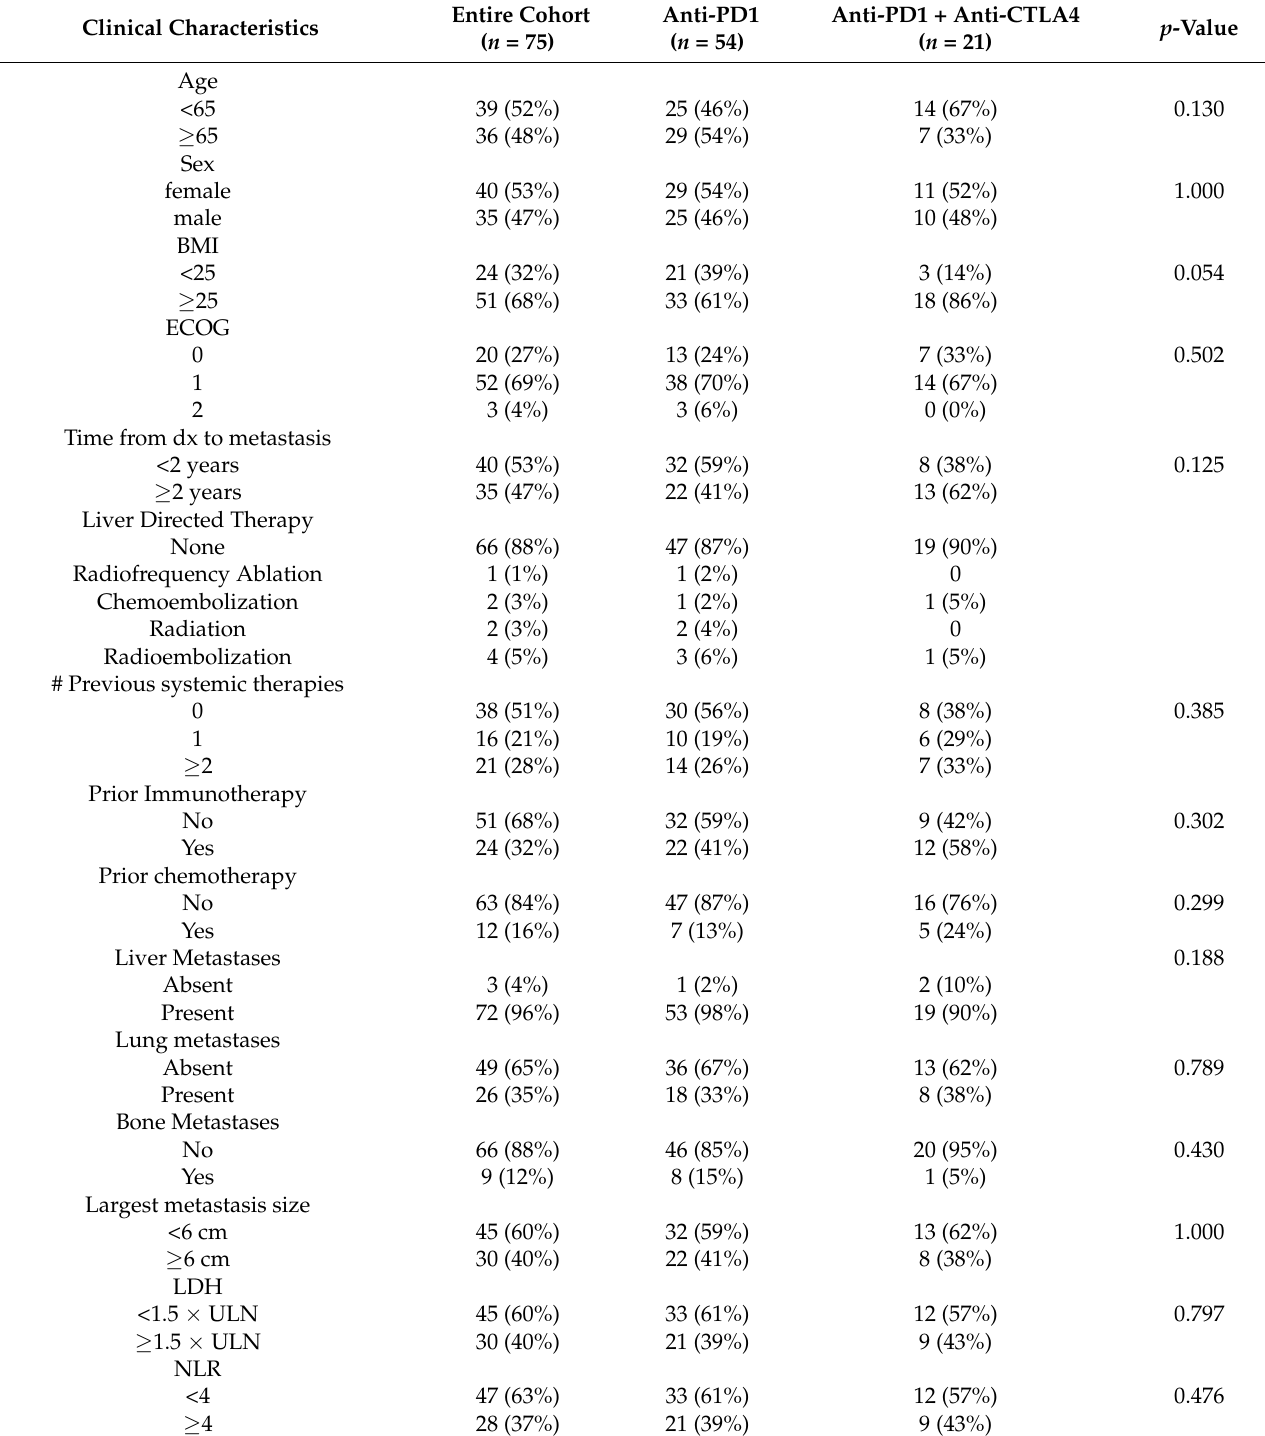
Table 1. Clinical characteristics of 71 mUM patients who received 75 lines of anti-PD1/L1 +/ − anti-CTLA4 ICI. Clinical